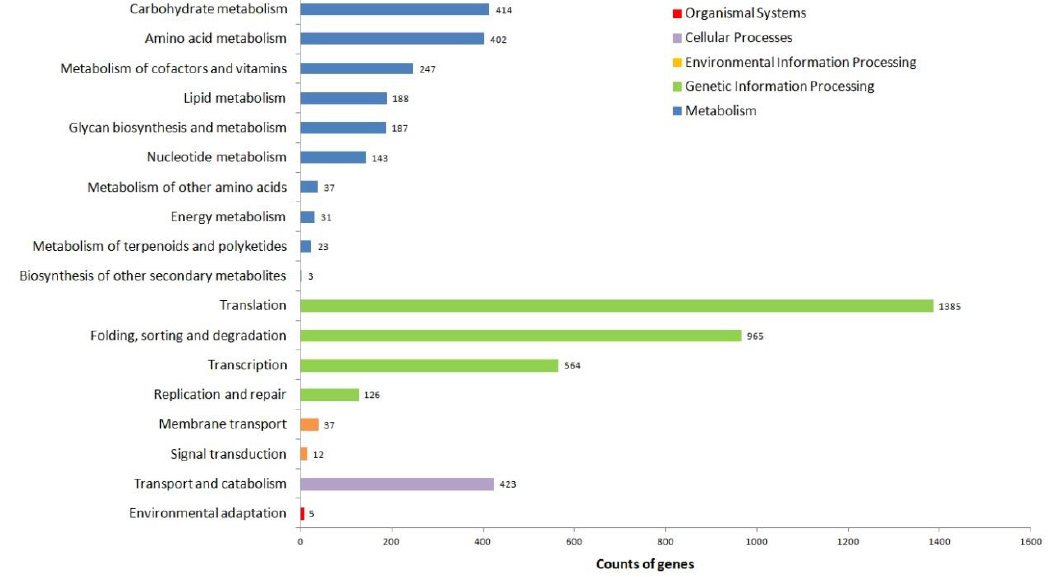
Figure 2. Annotated pathways and numbers of unique transcripts of M. rosenbergii by KEGG data-